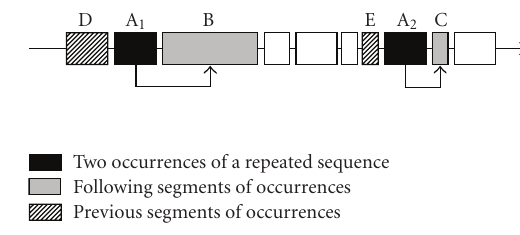
Figure 8: Illustration of adjacent segments to the occurrences of a repeated